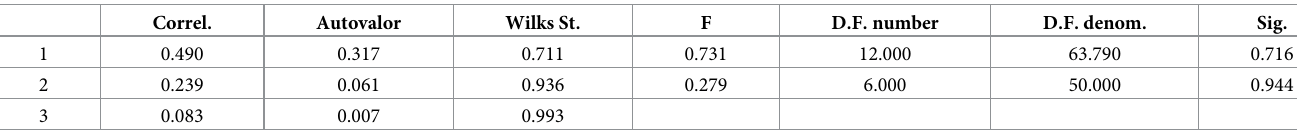
Table 5. Canonical Correlations: Experimental group before the experiment. Correl. Autovalor Wilks St. F D.F. number D.F. denom.